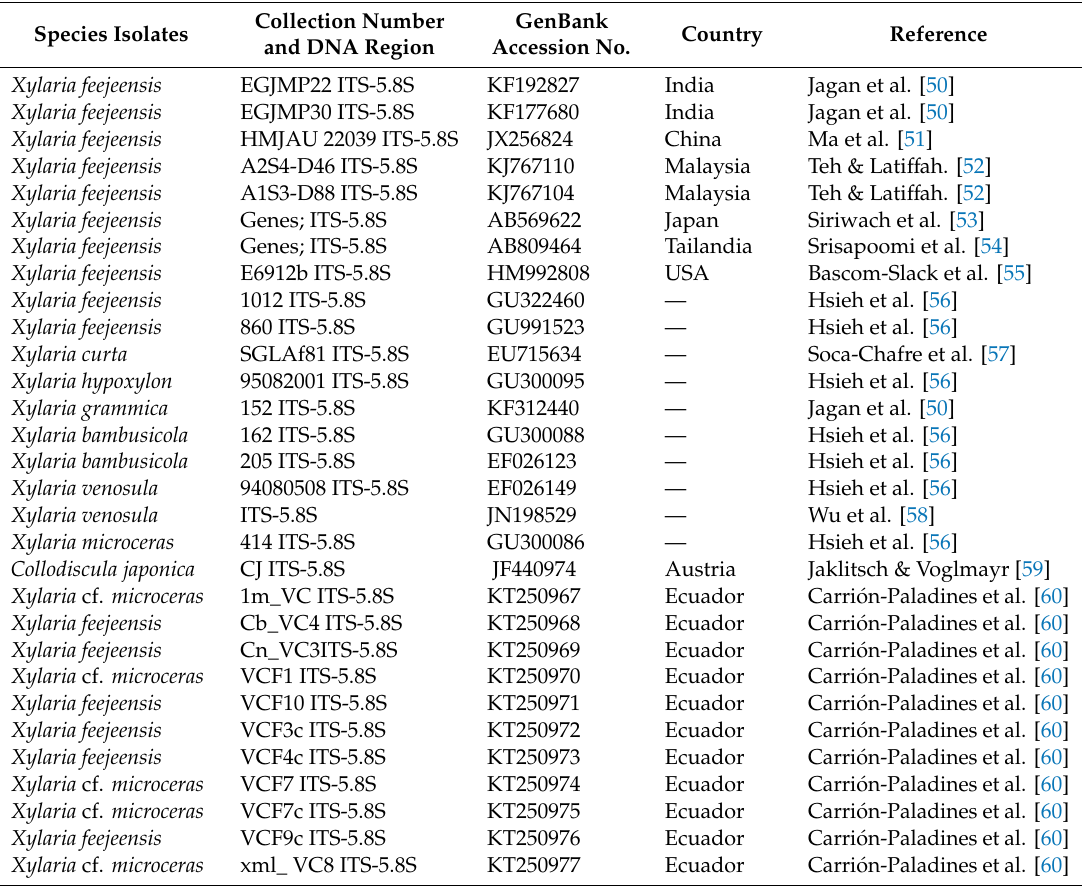
Table 1. Of accessions in the GenBank of species used for phylogenetic analyses (https: // www.ncbi.nlm.